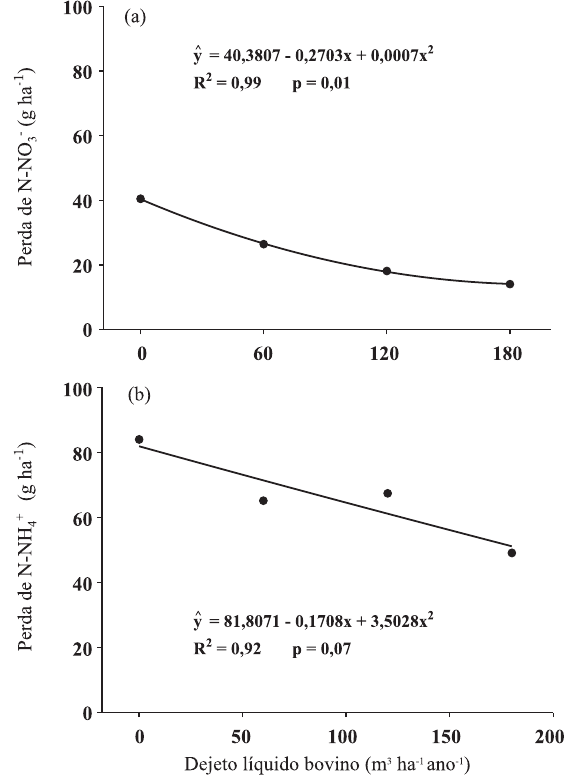
Figura 4. Perda acumulada de N-NO 3- (a) e N-NH 4+ (b) em escoamento superficial sob chuva natural após a aplicação de doses de dejeto líquido bovino em Latossolo franco-argiloarenoso manejado sob plantio direto. Ponta